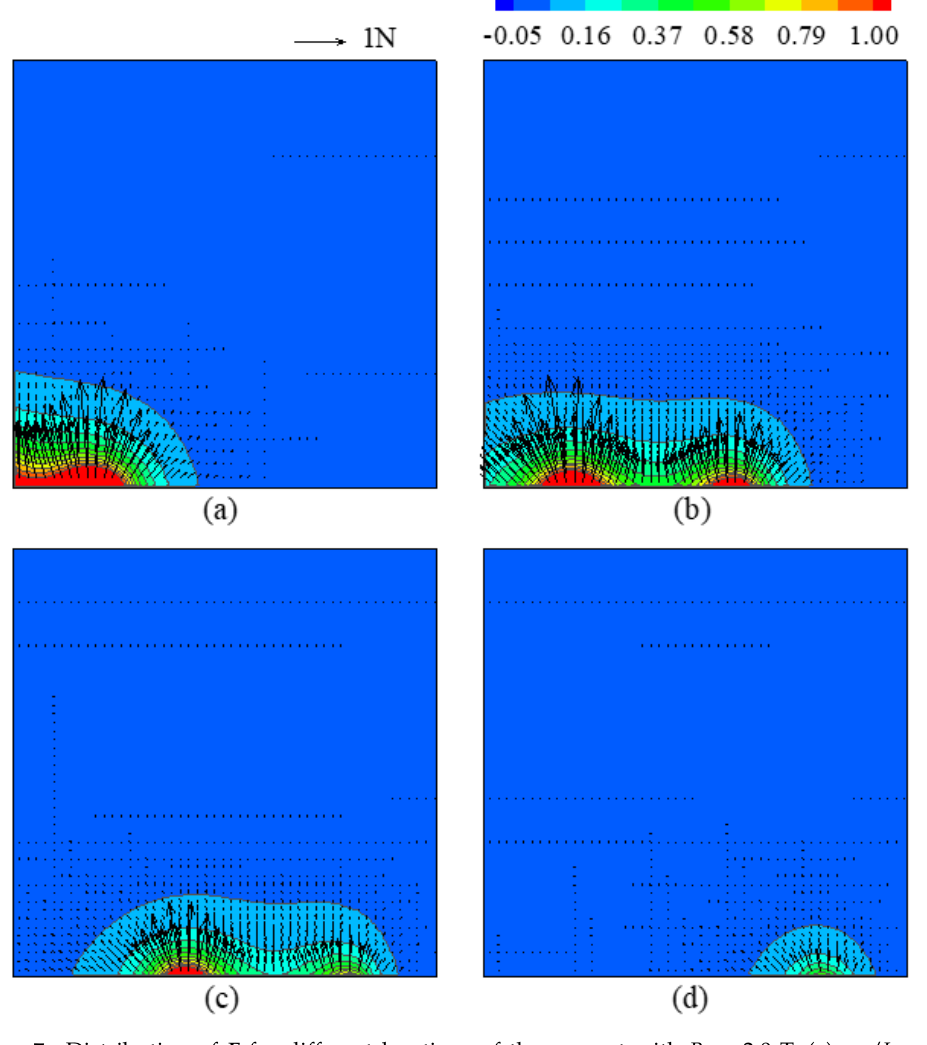
Figure 7. Distribution of F for different locations of the magnet with Br = 2.0 T; ( a ) x m / L = 0.2, ( b ) x m / L = 0.4, ( c ) x m / L = 0.6, and ( d ) x m / L =